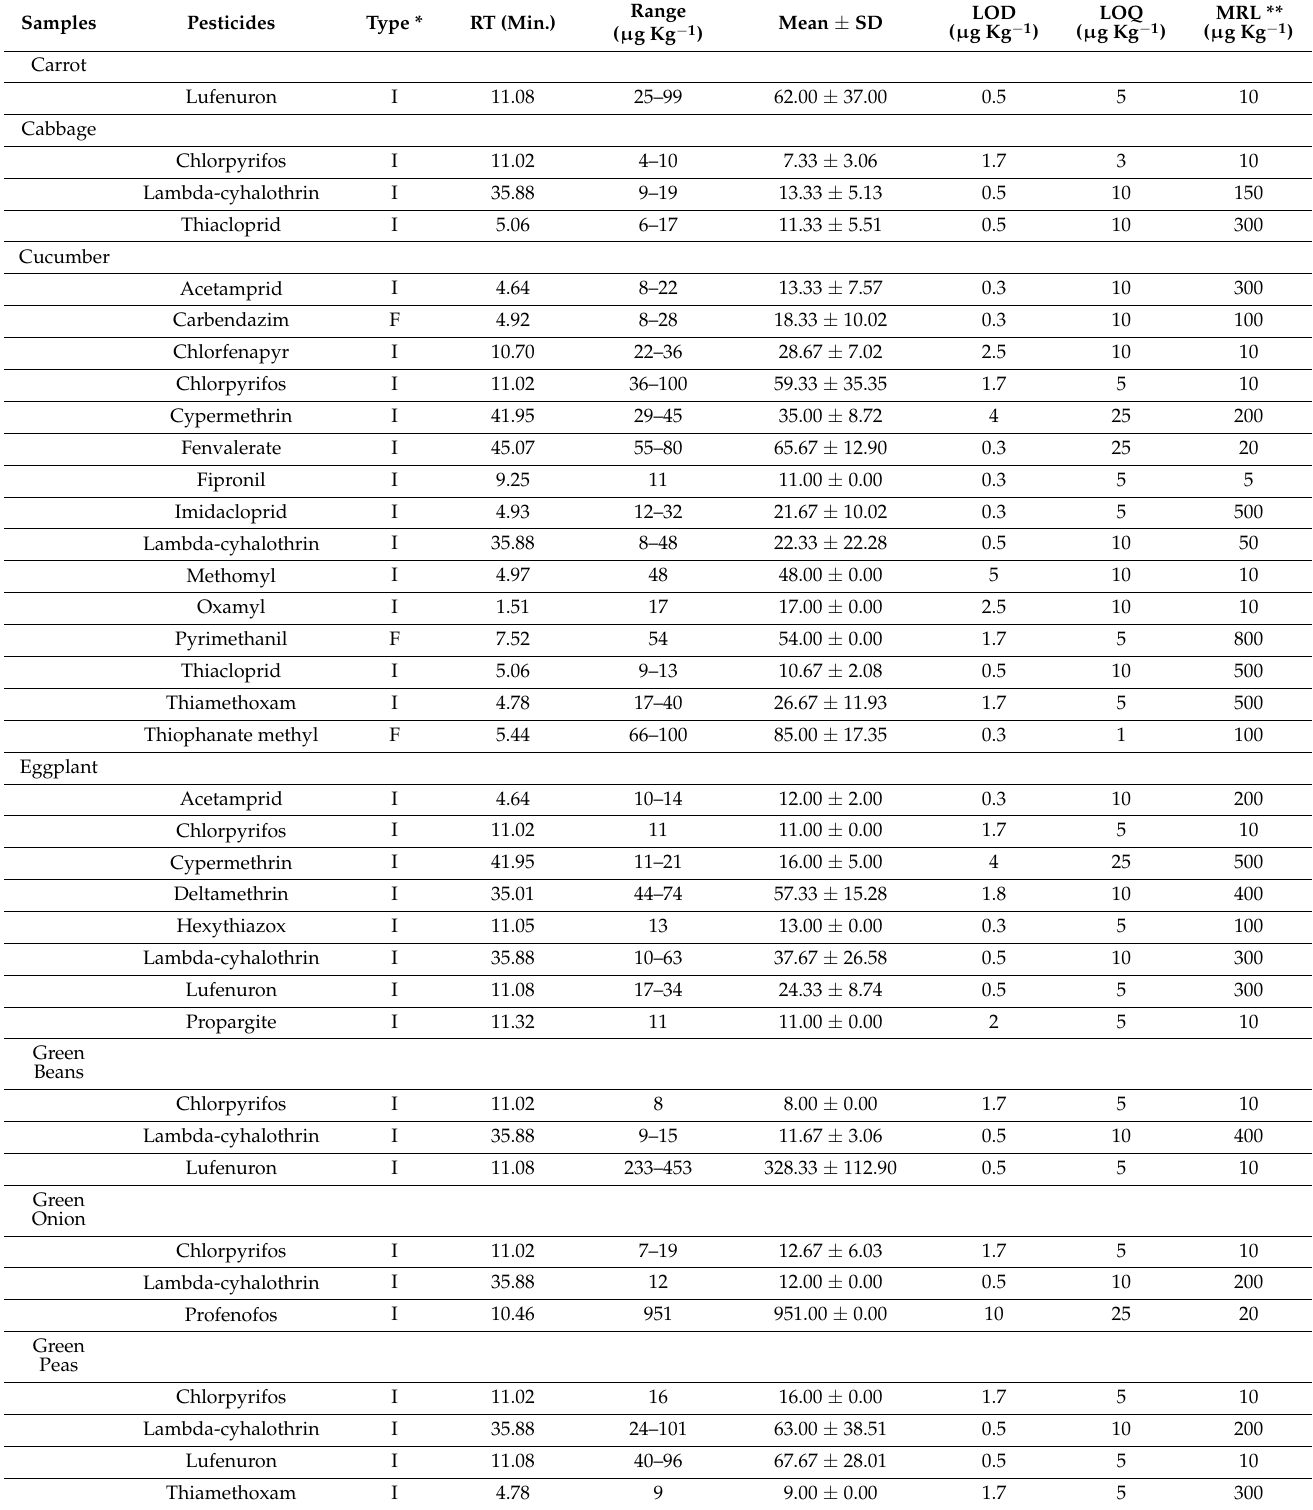
Table 1. Range and mean concentrations of pesticide residues ( µ g Kg − 1 ) found in vegetable sample collected from farmer markets in Sharkia Governorate,